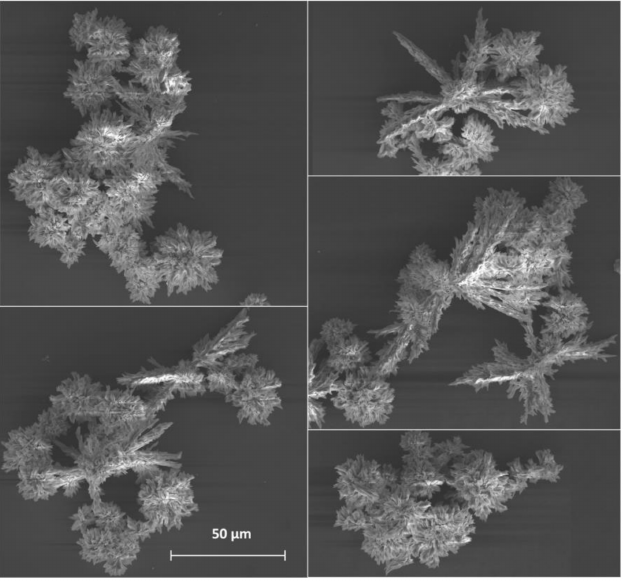
Figure 1. SEM images of Sample 1 . The average diameter of polycrystals is 120 ± 30 µ m.